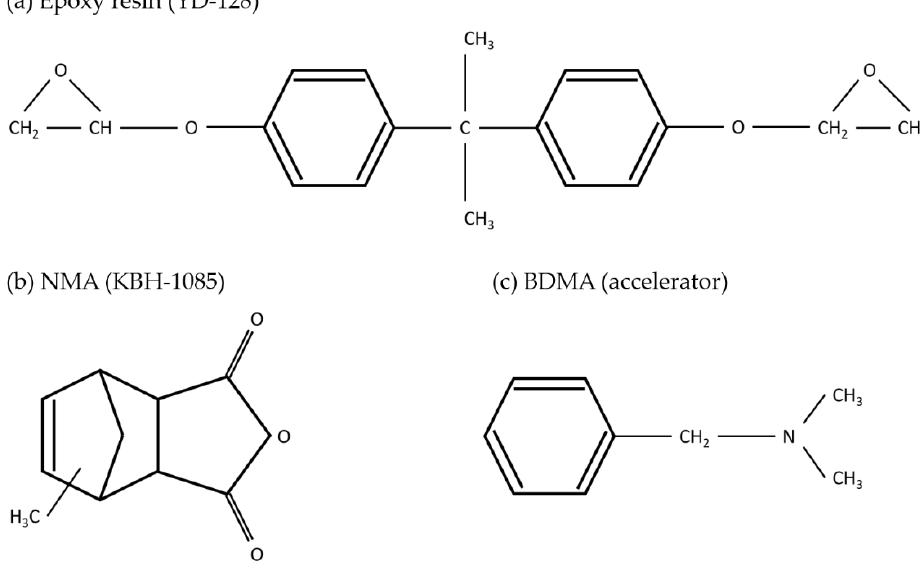
Figure 2. Chemical structures of ( a ) epoxy resin, ( b ) hardener, and ( c ) hardening